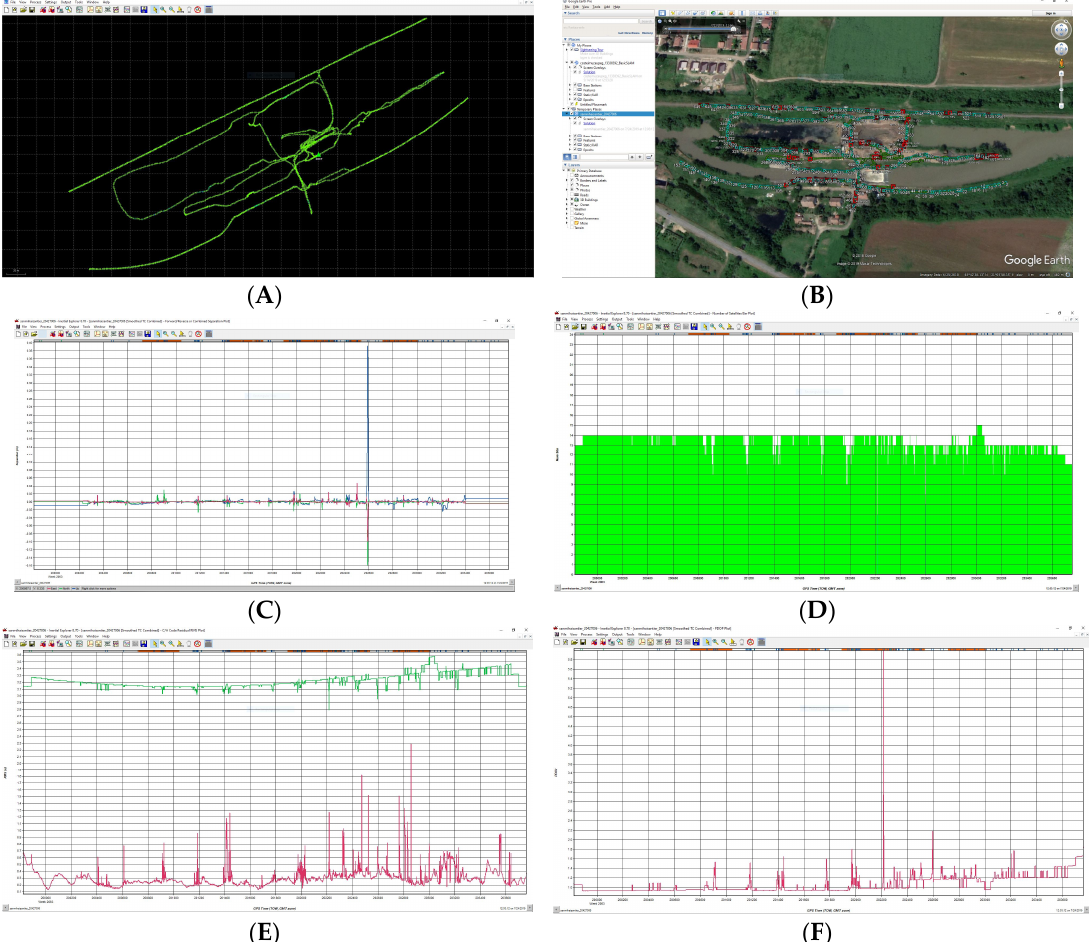
Figure 9. ( A ) Presentation of scanning trajectory; ( B ) View the trajectory in Google Earth; ( C ) View the Correctness of the Scan (Combined Separation); ( D ) Number of satellites visible at the time of scanning; ( E ) RMS values; ( F ) PDOP for the S â nmihaiu Rom â n Hydro technical Node on 23 July 2019. Within each group, the plots appear alphabetically in three colors: green, blue, and